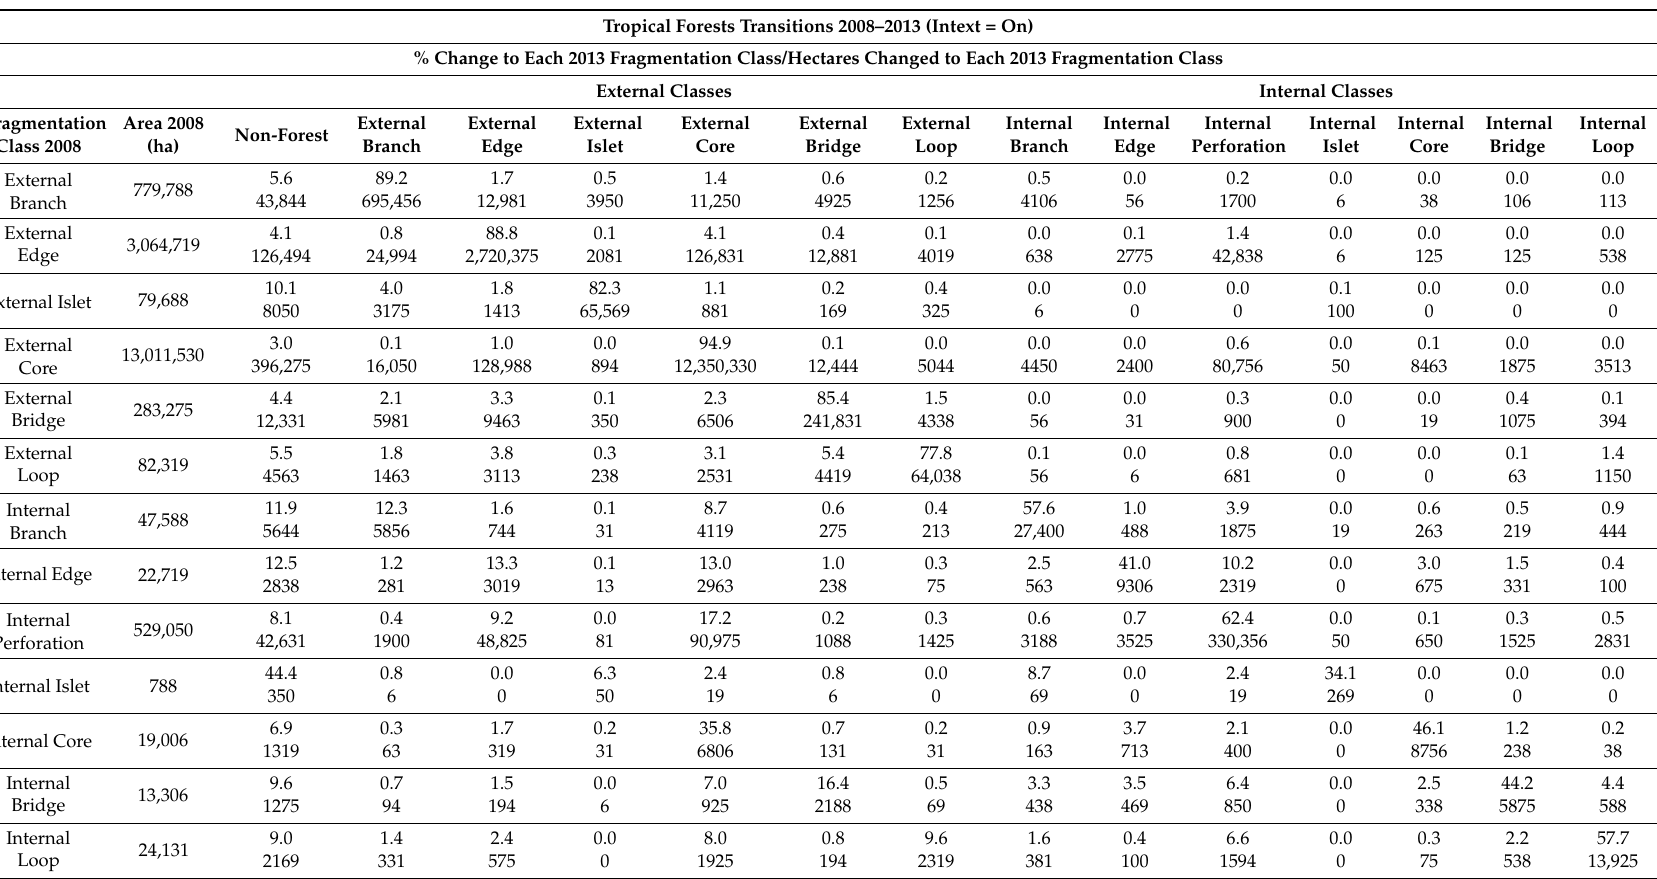
Table E1. Fragmentation classes transition matrix tropical forests in the 2008–2013 period differentiating between internal and external fragmentation classes. Tropical Forests Transitions 2008–2013 (Intext = On) % Change to Each 2013 Fragmentation Class/Hectares Changed to Each 2013 Fragmentation